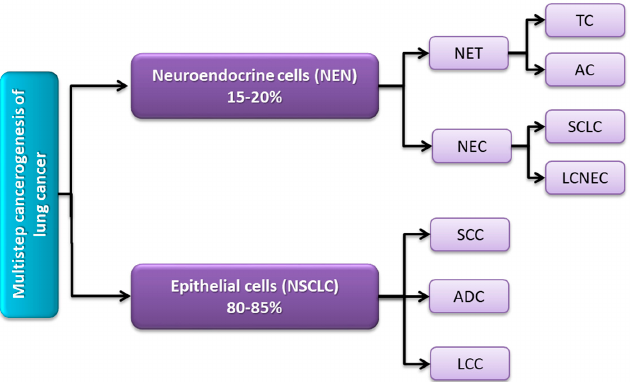
Figure 2. Classification of different subtypes of lung cancer (based on [30–32]).